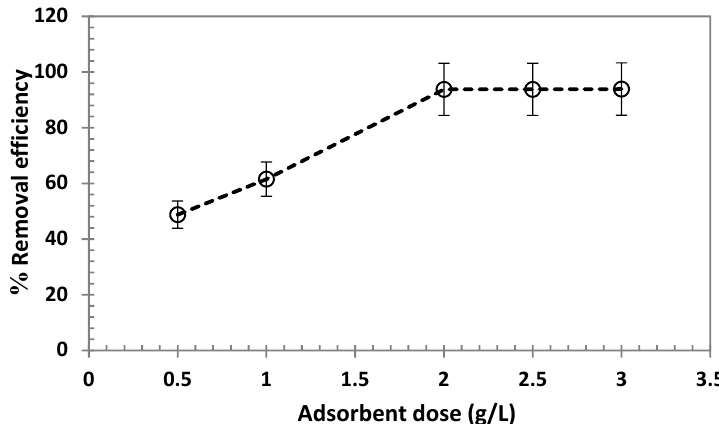
Figure 8. E ff ect of adsorbent dosage on arsenic removal e ffi ciency (initial arsenic concentration: 0.075 Figure 8. Effect of adsorbent dosage on arsenic removal efficiency (initial arsenic concentration: 0.075